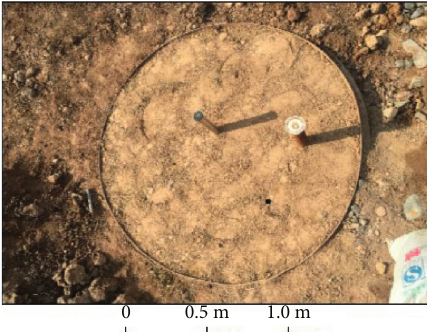
Figure 7: Reclaimed soil after one-compaction test